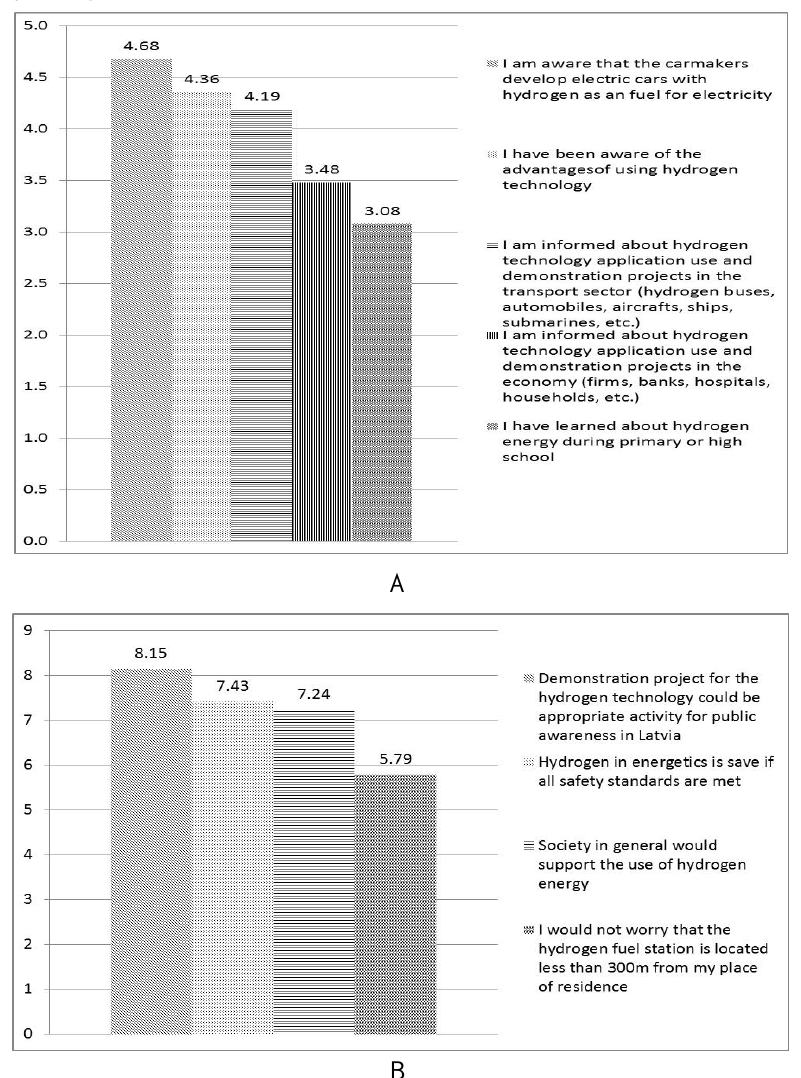
Fig. 5. Arithmetic mean of responses on statements on public knowledge on hydrogen in energetics (evaluation scale 1 to 10, where 1 − fully disagree, 10 − fully agree; Public survey by J. Dimants, B. Sloka, J. Kleperis, 2013, n = 1299)